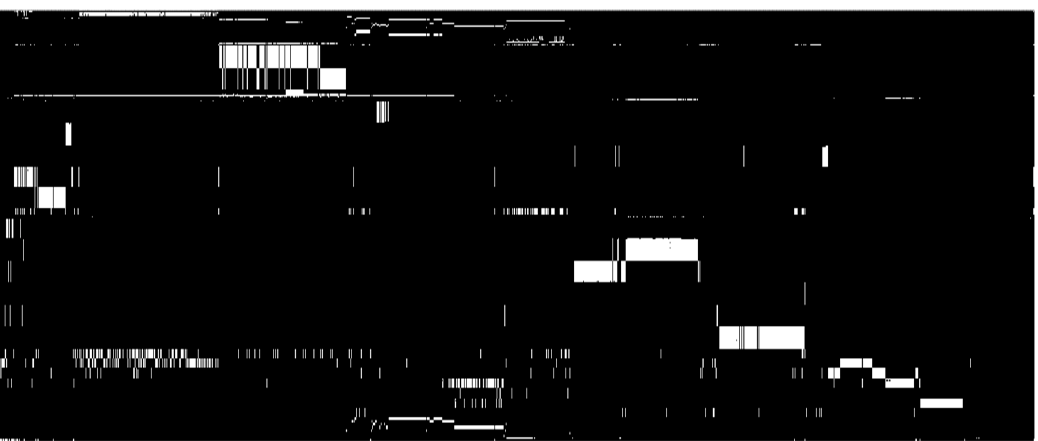
Figure 4. Genomewide haplotype capture in sorghum using genomewide SNPs (single nucleotide polymorphisms), three sets of target genes, geographic data, and environmental data to assemble subsets. X-axis, average physical length of haplotype blocks (Kbp). Y-axis, rescaled relative enrichment of haplotypic diversity genomewide, zero is random expectation. Points are coded by reference data source: triangle, whole genome; ‘l’, lignin biosynthetic genes; ‘r’, regulatory genes; ‘c’, climate adaptation genes; plus sign, geography; circle, environment.